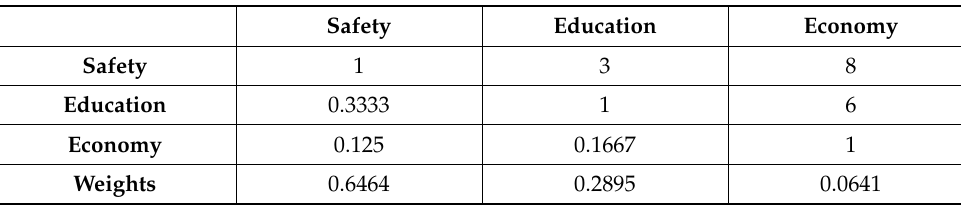
Table 19. Pairwise Comparison Matrix for